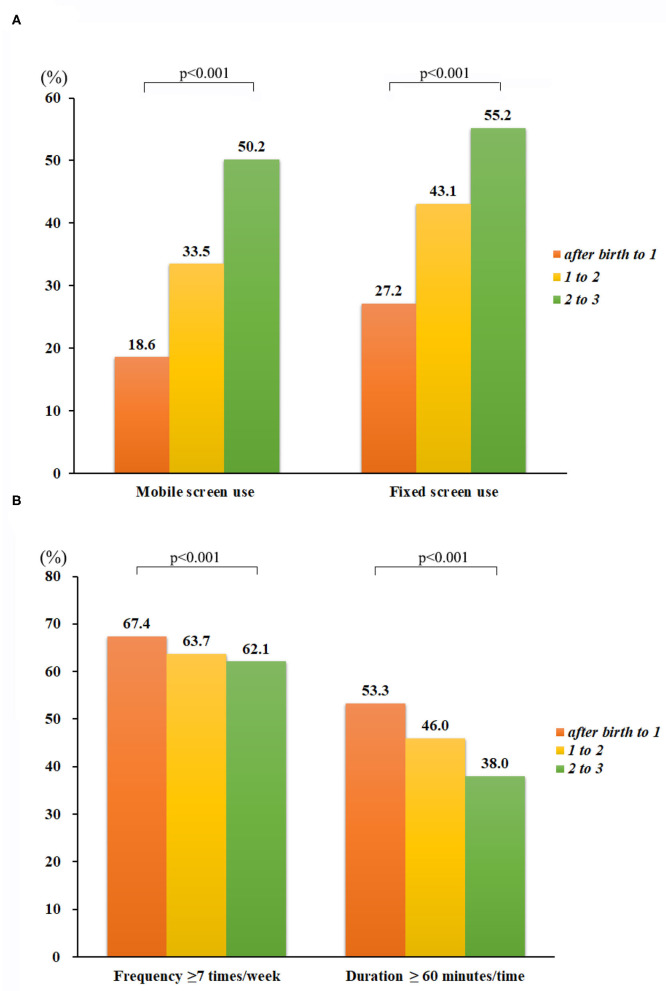
Yearly outdoor activity and screen use from 1 to 3 years of age. During the first 3 years after birth, the proportion of children who went outdoors for ≥7 times/week declined, from 67.4% at age 1 year to 62.1% at age 3 years, as did the proportion of children who spent ≥60 min outdoors, from 53.3% at age 1 year to 37.4% at age 3 years. In contrast, the proportion of children exposed to fixed screen devices increased from 17.7% at age 1 year to 55.3% at age 3 years, and the proportion of children exposed to handheld mobile devices went from 18.6% at age 1 year to 40.2% at age 3 years.